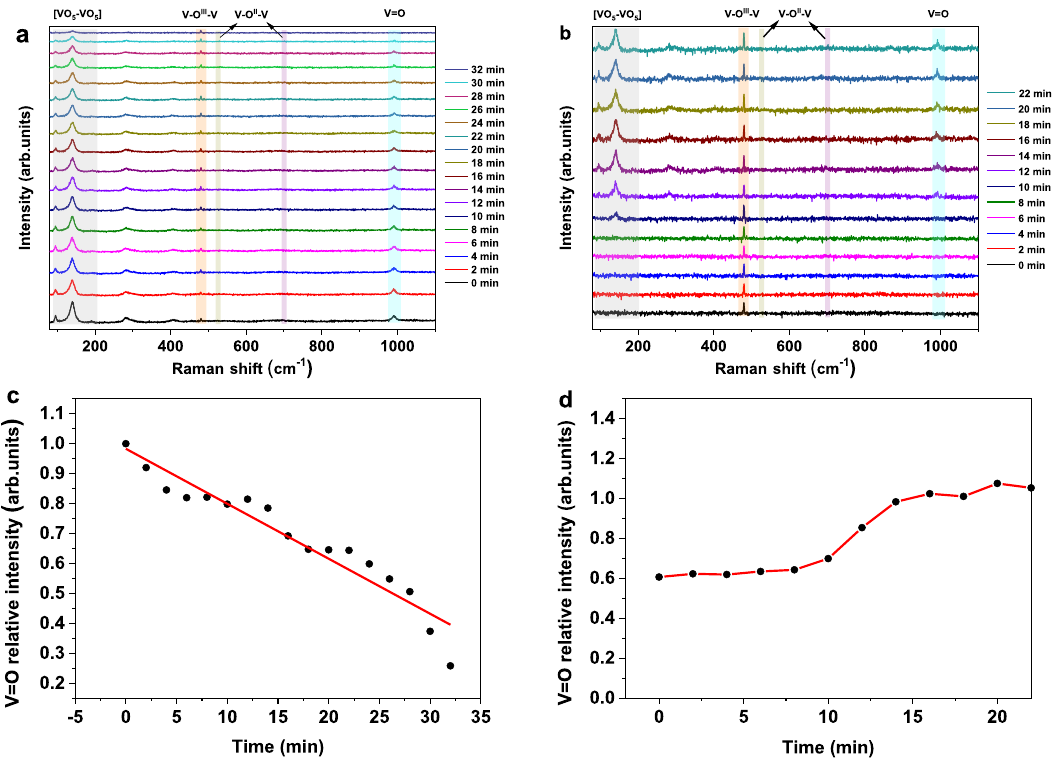
Fig. 4 In-situ Raman spectroscopy. In situ Raman spectra of V 2 O 5 redox catalyst during the a reduction and b subsequent re-oxidation as a function of time. Reaction conditions: reduction, 5% NH 3 /Ar (2.2 ml/min); oxidation, 30% O 2 /Ar (2.2 ml/min); temperature, 650 o C. The corresponding V = O relatively intensity evolution during the c reduction and d re-oxidation step. V = O relatively intensity equals V = O reduced (oxidized)/V = O at full oxidation state.